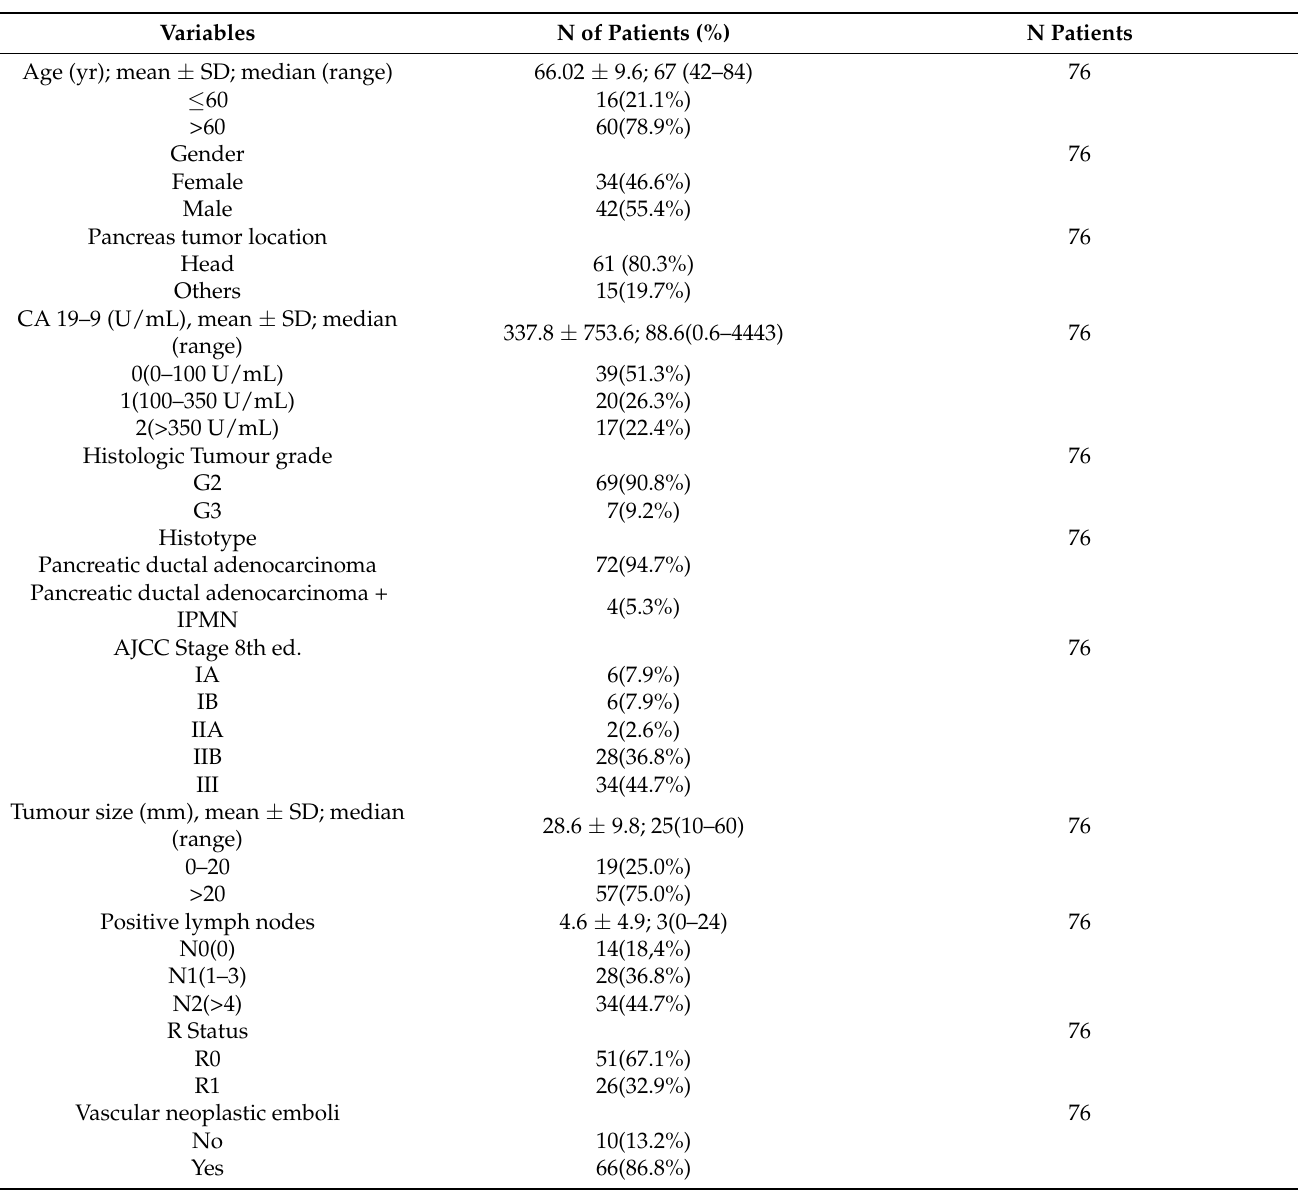
Table 1. Patients clinicopathological